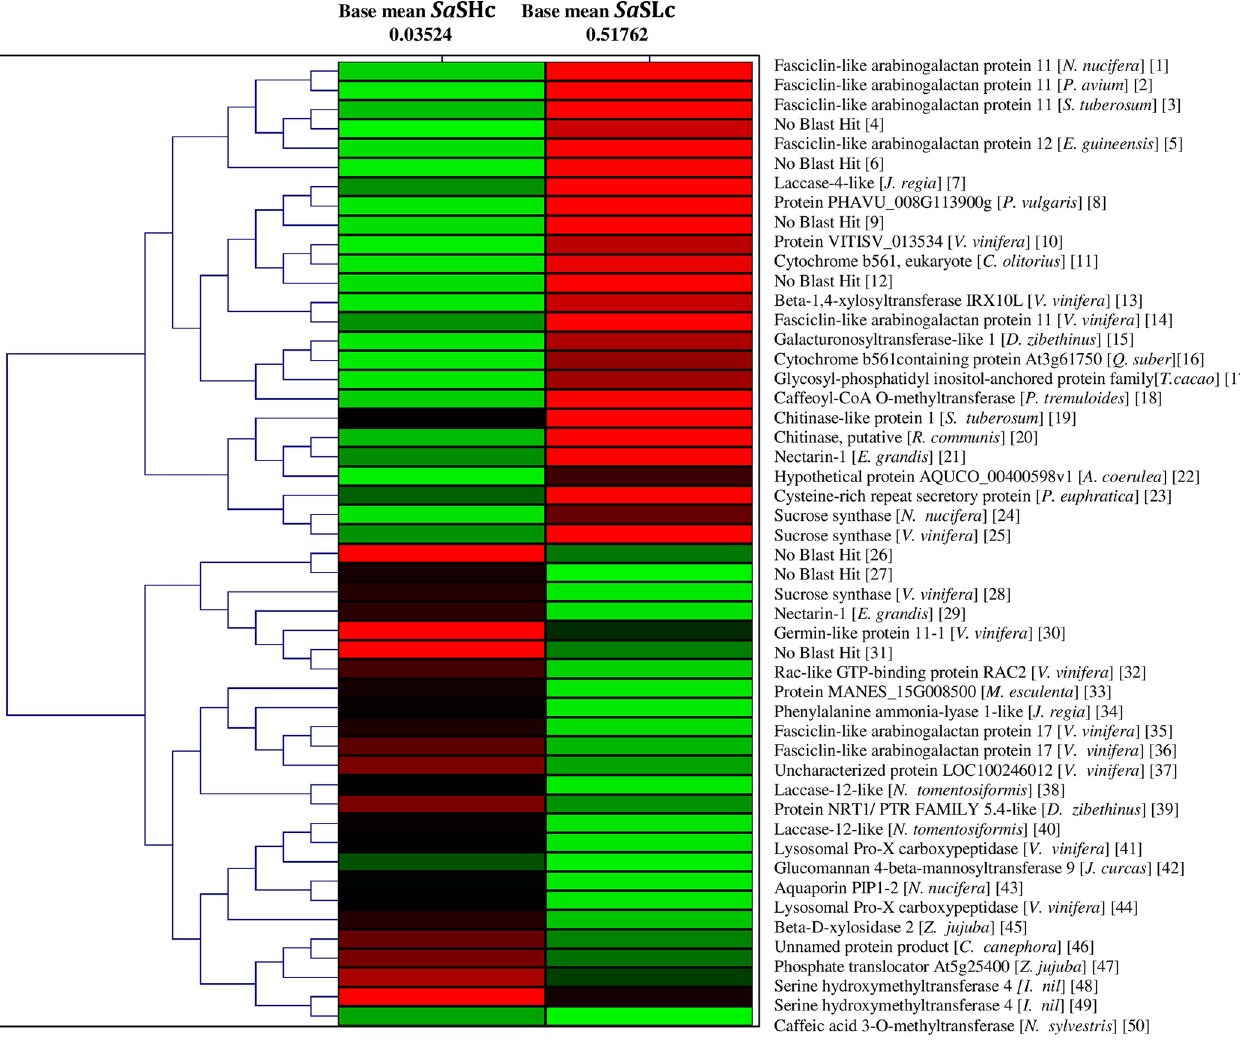
PLOS ONE | https://doi.org/10.1371/journal.pone.0252173 April 28,